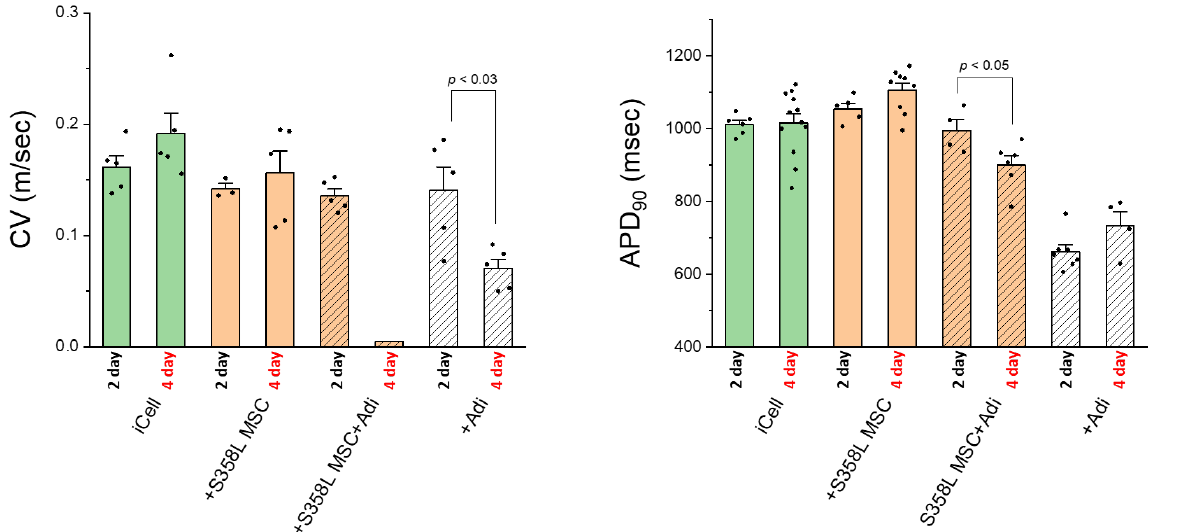
Figure 8. Summary data for conduction velocity (CV, left) and APD 90 (right) when iCell cardiac myocytes (iCell CM) were co-cultured under 2 or 4 days of early adipogenic conditioning. Co-culturing with S358L (+S358L MSC) MSCs (orange bars) had no effect on CV or APD 90 at 2 or 4 days. Only when pro-adipogenic factors alone (white hatched bars) or when combined with S358L (+S358L MSC + ADI) MSCs (orange hatched bars) was CV and APD 90 significantly reduced at 4 days compared to 2 days. For CV: iCell, n = 5, n = 5; +S358L MSC, n = 3, n = 5; +S358L MSC + Adi, n = 5, n = 5; +Adi, n = 5, n = 5. For APD 90 : iCell, n = 6, n = 12; +S358L MSC, n = 5, n = 9; +S358L MSC + Adi, n = 4, n = 6; +Adi, n = 7, n = 4.